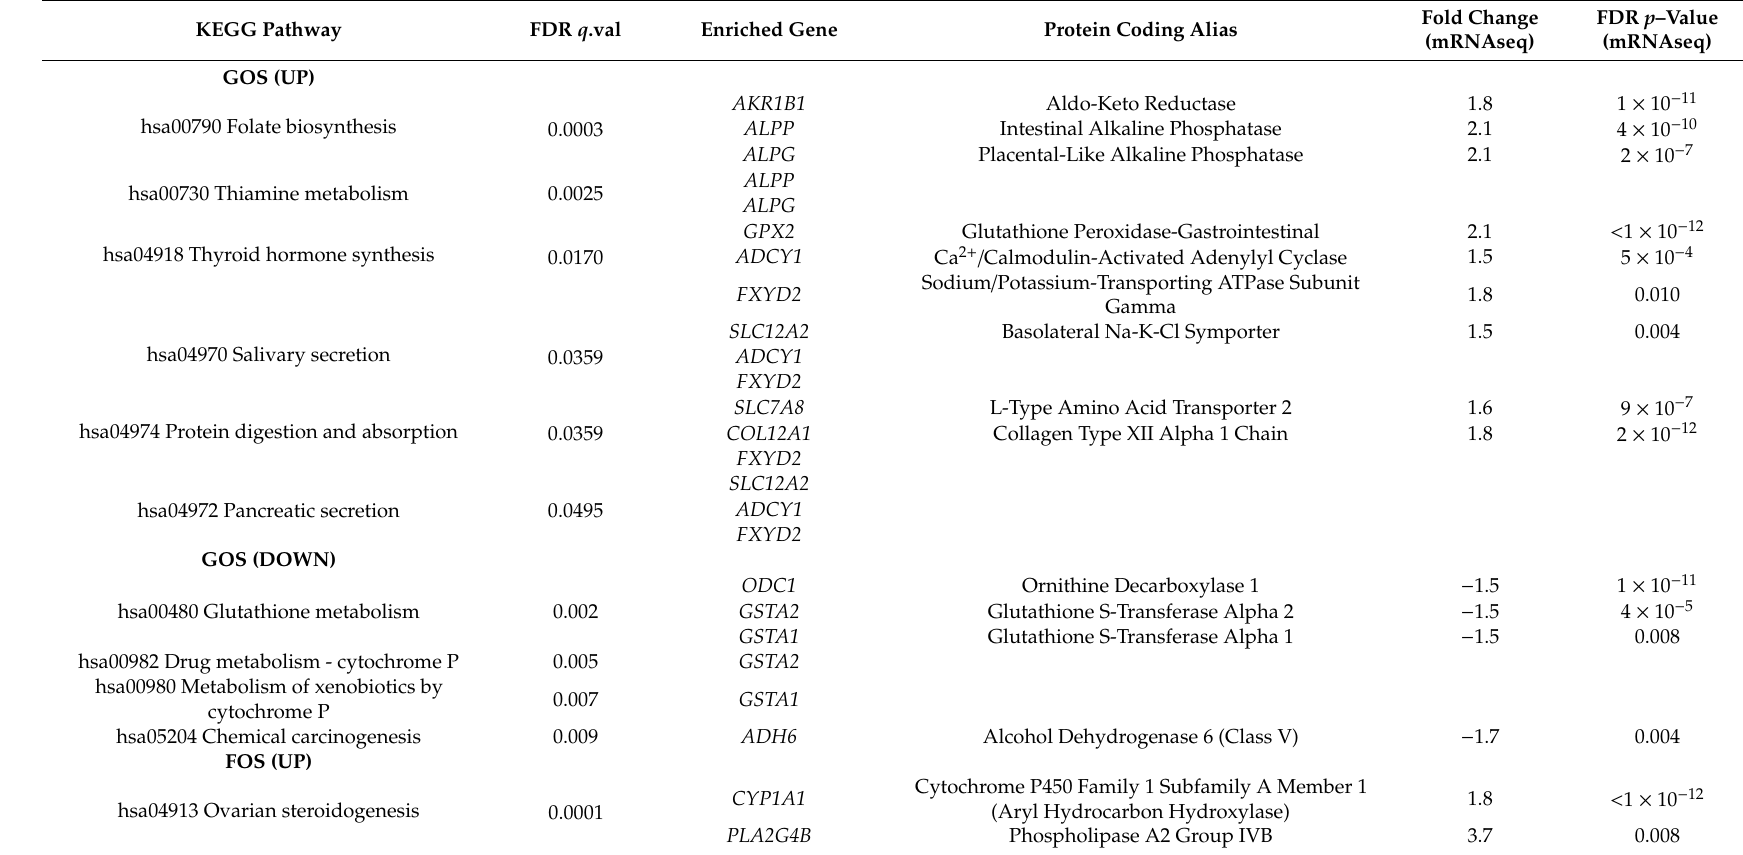
Table 5. Kyoto Encyclopedia of Genes and Genomes (KEGG) pathway analysis. Enriched pathways among the di ff erentially expressed genes were identified by KEGG analysis. Di ff erentially expressed gene false discovery rate (FDR) p-adj. < 0.05 and absolute value of fold change ≥